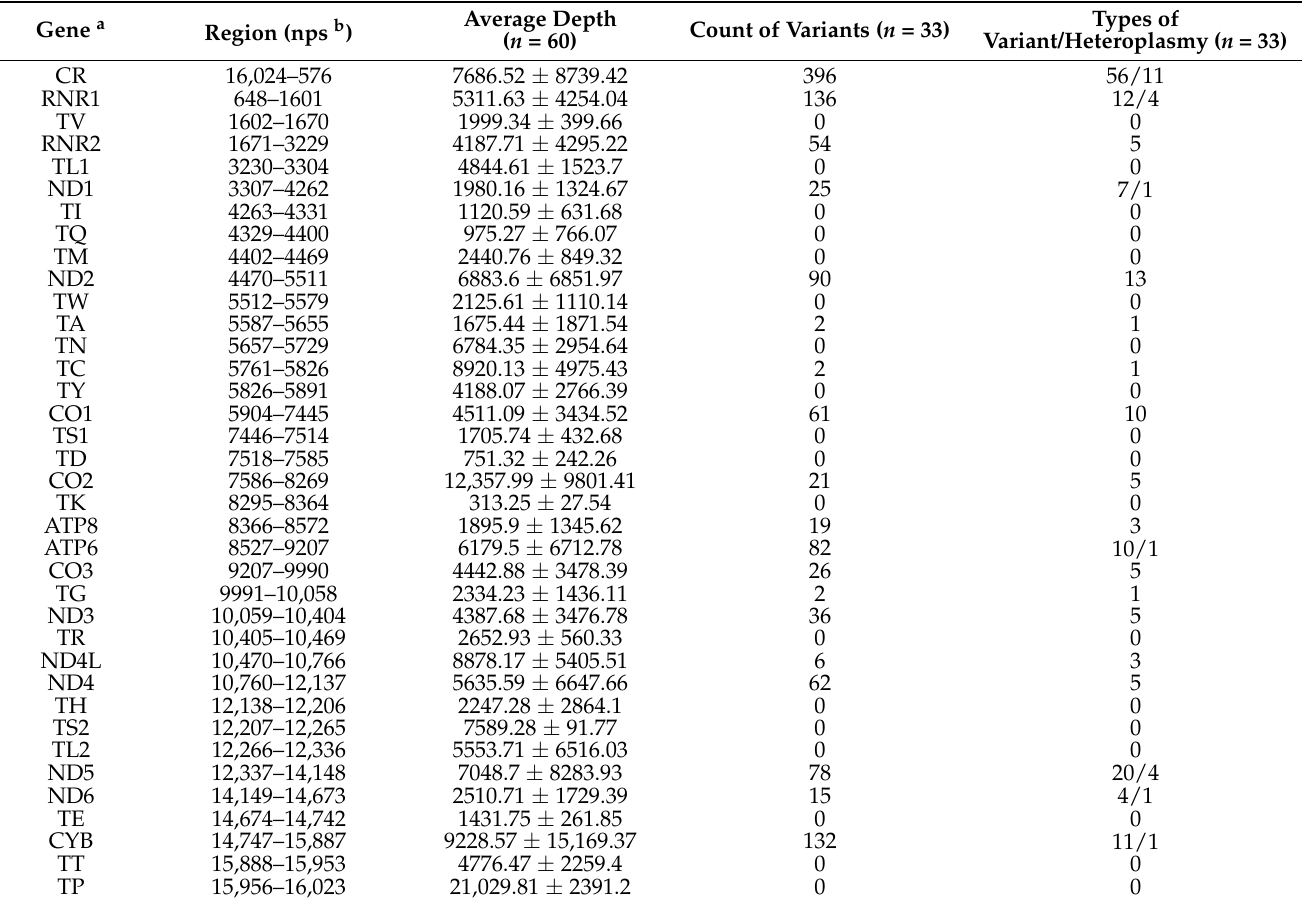
Table 2. Average read depth, count of variants, and count of variant types in control region and the 37 gene-coding